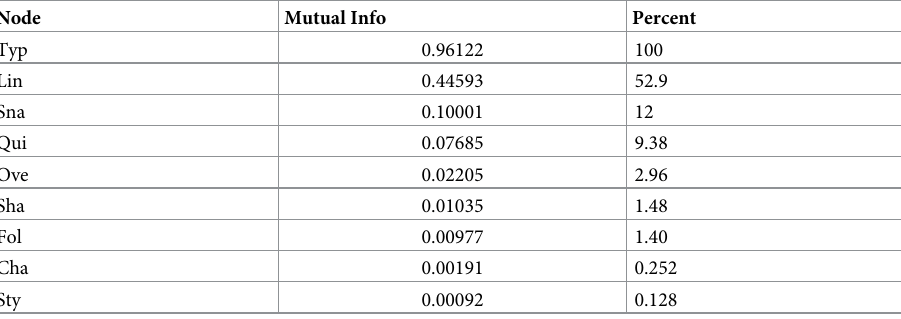
Table 7. Sensitivity analysis results of node Typ.